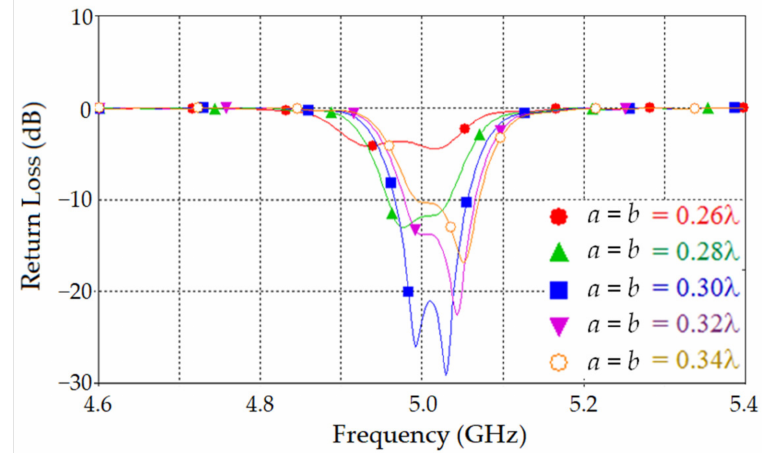
Figure 10. Simulated return loss for different values of ‘ a ’ and ‘ b ’.